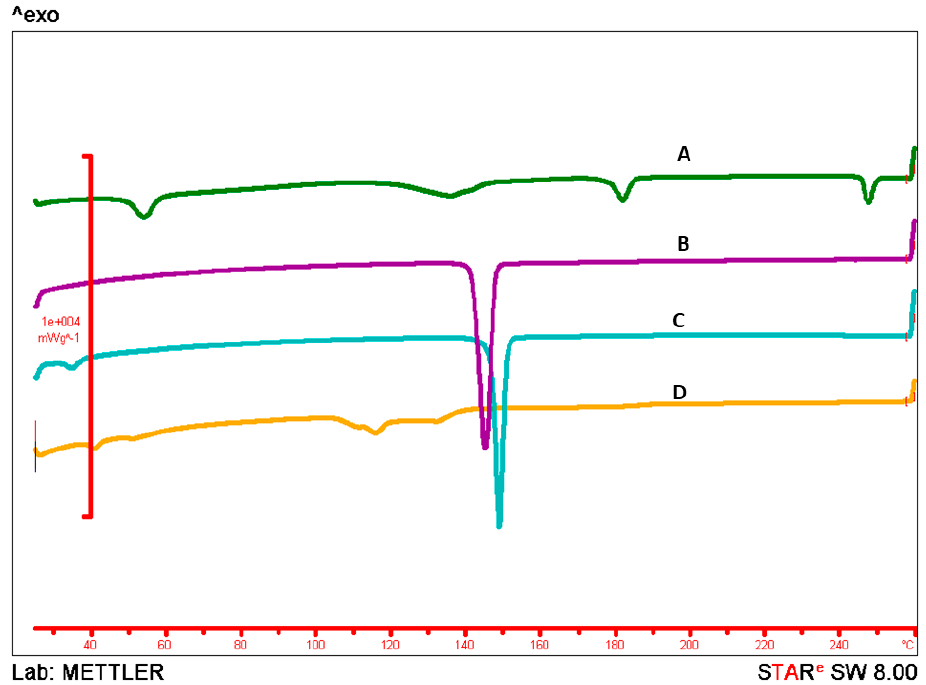
Figure 5. Differential scanning calorimetry (DSC) Thermograms of (A) sodium oleate, (B) Figure 5. Di ff erential scanning calorimetry (DSC) Thermograms of ( A ) sodium oleate, ( B ) clotrimazole, clotrimazole, (C) cholesterol, and (D) clotrimazole loaded ufosomes. Sharp endothermic peaks in ( C ) cholesterol, and ( D ) clotrimazole loaded ufosomes. Sharp endothermic peaks in thermograms thermograms (B) and (C) indicates the melting points of clotrimazole and cholesterol at 147.63 °C and ( B , C ) indicates the melting points of clotrimazole and cholesterol at 147.63 ◦ C and 143.98 ◦ C, respectively. 143.98 °C, respectively. No peak related to the drug was found in clotrimazole loaded ufosomes (D). No peak related to the drug was found in clotrimazole loaded ufosomes ( D